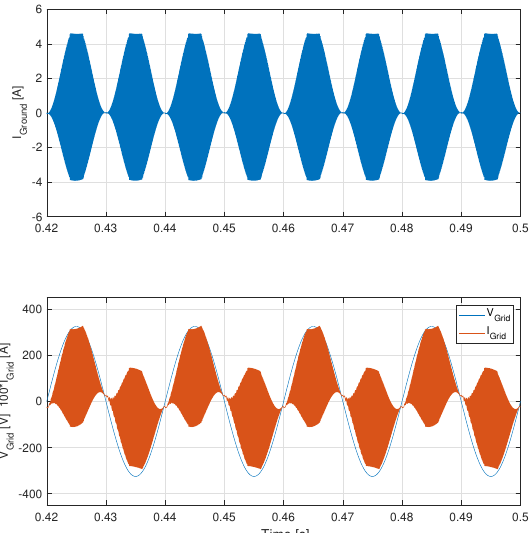
Figure 12. Ground leakage current waveform (top), injected grid current waveform ( × 100), and grid voltage waveform (bottom) in the case of CSI basic topology. The Root Mean Square RMS of the ground leakage current is equal to 1.83 V RMS .